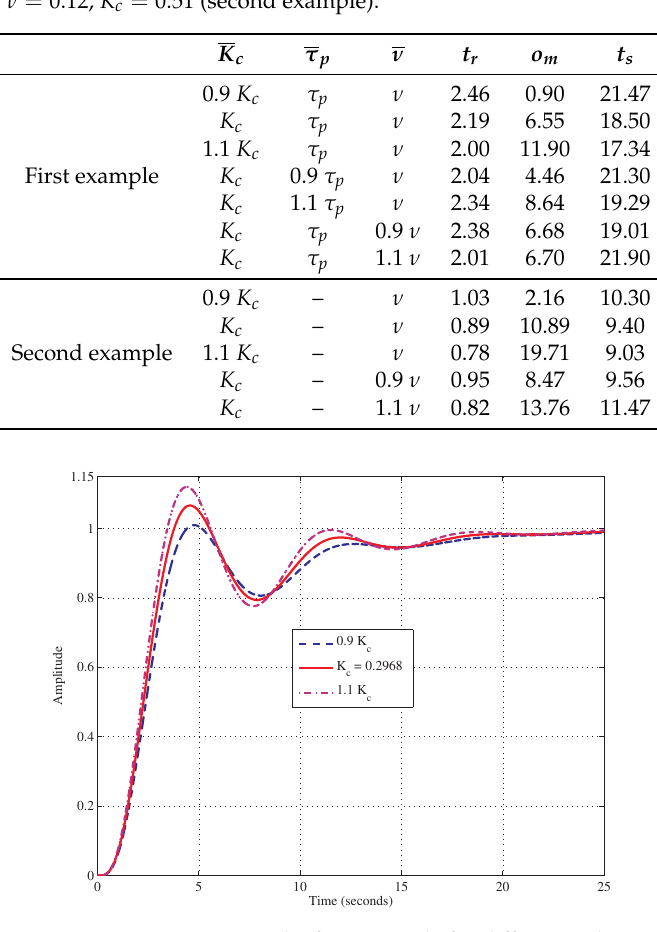
Table 1. Characteristics of the step response with parameter variations: t r , t s (expressed in seconds), o m (in % values). Changing parameters: K c , τ p , ν . Design values: τ p = 1, ν = 0.33, K c = 0.30 (first example); D = 1, ν = 0.12, K c = 0.51 (second example).